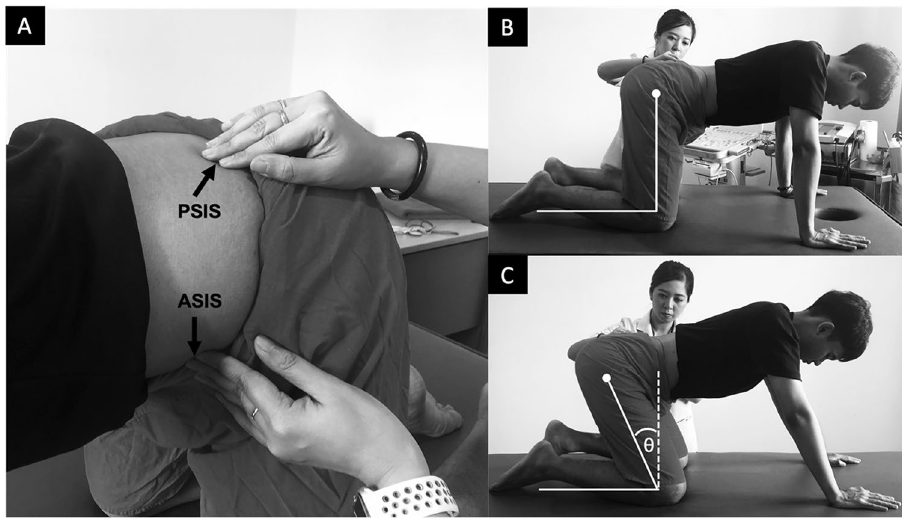
Figure 2. Hand placement at anterior superior iliac spine (ASIS) and posterior superior iliac spine (PSIS) to monitor pelvic position ( A ) during quadruped rocking backward from starting position ( B ) until the pelvis starts to move posteriorly ( C ) where knee flexion angle (θ) used to represent motor